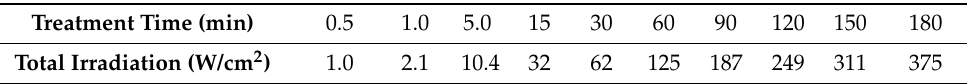
Table 1. Treatment time and total irradiation (W/cm 2